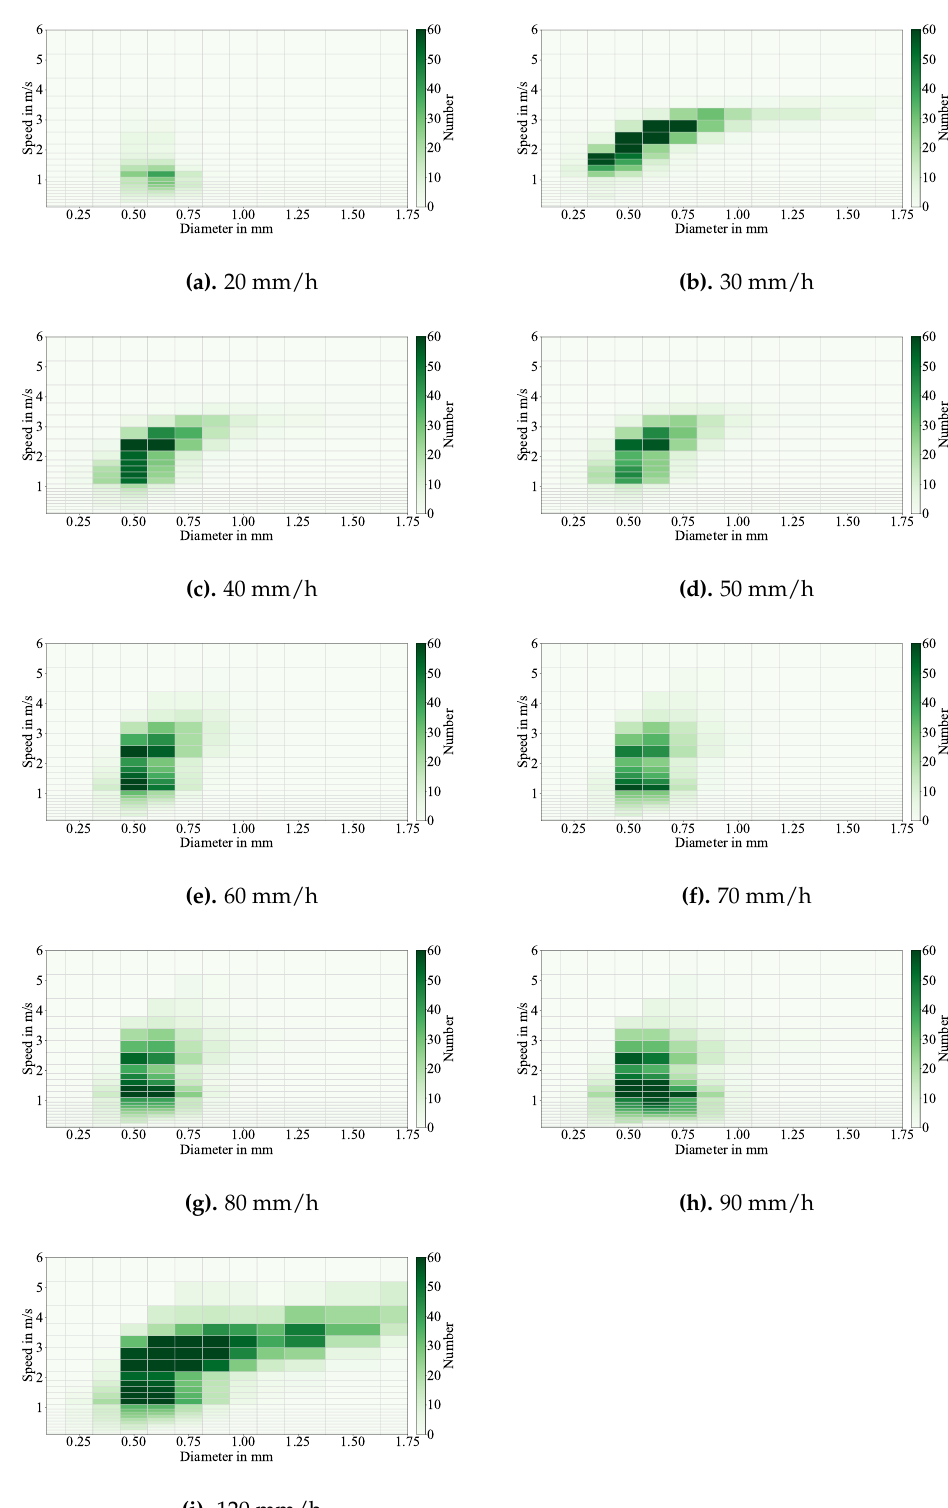
Figure 11. Speed-diameter histograms from rain experiments. VLP-32: The sensor is capable of producing its nominal number of points on the target for rain precipitations of 30 mm/h to 50 mm/h but the target is almost lost (below 20%) for precipitation values of 70, 80 and 90 mm/h. The intensity of these points are all above 20% of the nominal value and have the tendency to slowly decrease from 80% at 30 mm/h to 30% at 90 mm/h. The 20 mm/h rain rate shows a depletion of the number of points to